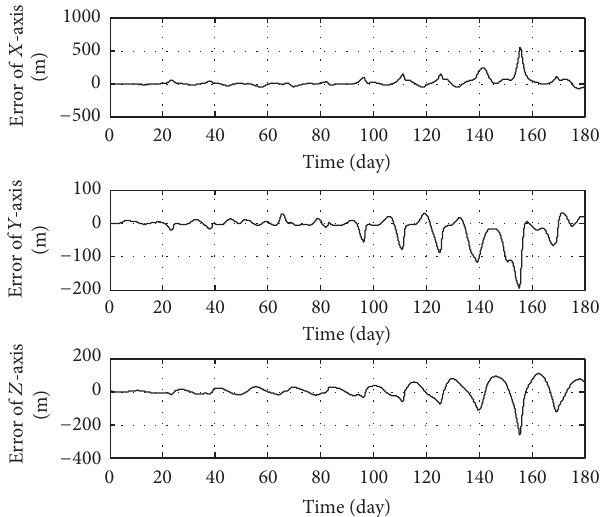
Figure 6: The AOD position error of 𝐿 2 using